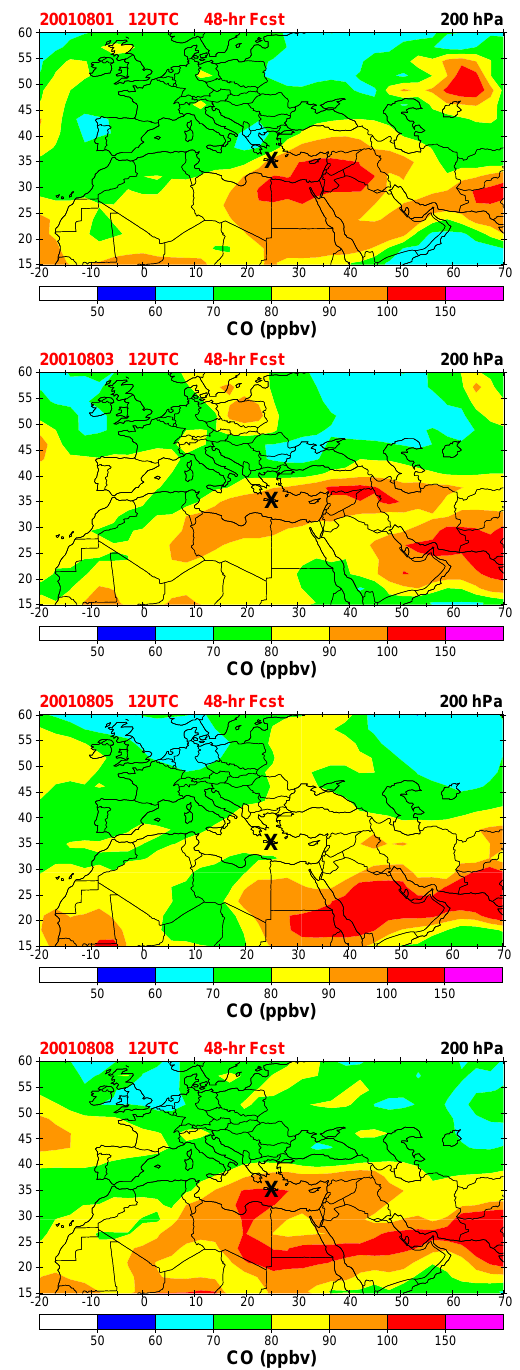
Fig. 46. Forecasts of the southern Asian summer monsoon plume distribution at different times during the MINOS campaign in early August 2001, from the MATCH-MPIC model for the days of the first three flights (1, 3 and 8 August), along with the forecast for 5 August showing the contrast when a strong plume is not present over the eastern Mediterranean (from Lawrence et al., 2003a, copy- right 2003 by the European Geophysical Union, modified with